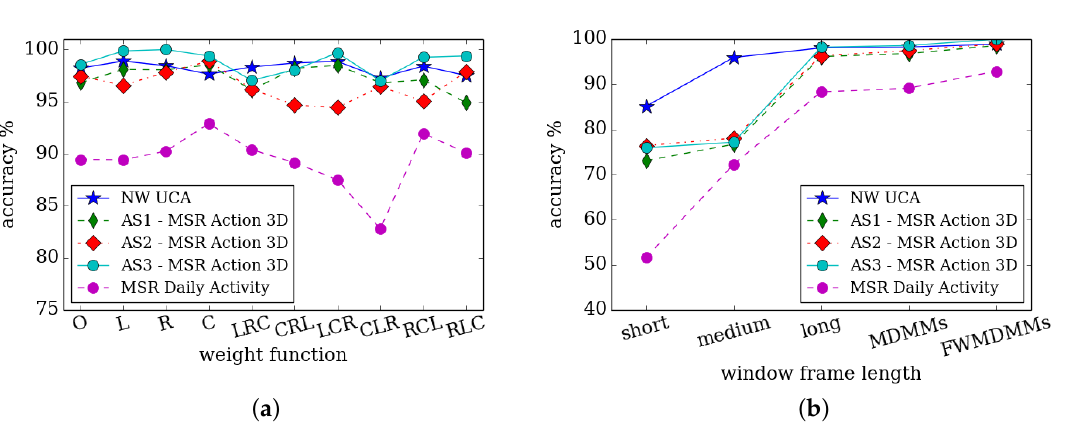
Figure 11. ( a ) Recognition rates based on various weight functions of FWMDMMs concatenated with spatial information. Results are in terms of NUCLA, MSR 3D action subsets and MSR daily activity datasets. The abbreviations, O, L, R and C are the original MDMM, linear, reversed linear and central-oriented fuzzy weight functions, respectively. ( b ) Effects of various lengths of frames based DMMs computation with MDMMs and FWMDMMs on the recognition